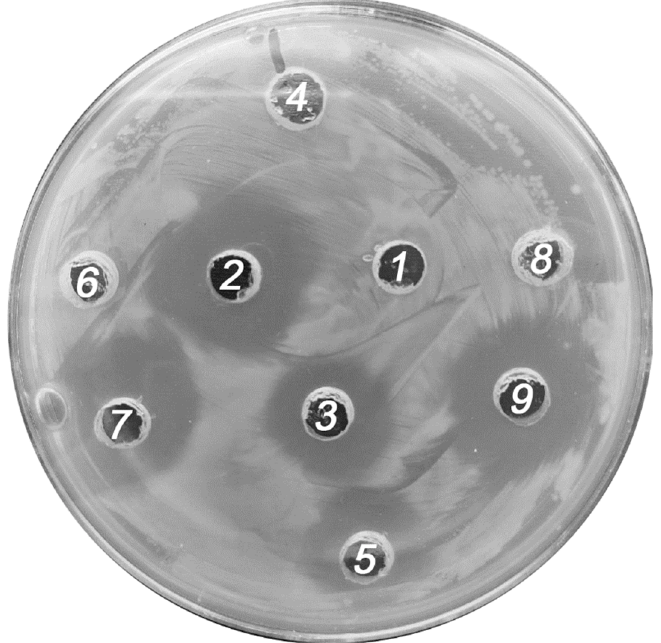
Figure 5. Photo of a Petri dish with agar LB medium inoculated with E. coli , after the formation of sterile zones. There are solutions in the wells: 1—{Mo 72 Fe 30 }; 2— ТС ; 3—{Mo 72 Fe 30 }@ ТС 12.5 ; 4—{Mo 72 Fe 30 } destruction products (DP); 5— ТС +DP; 6—FeCl 3 ∙ 6H 2 O; 7— ТС +FeCl 3 ∙ 6H 2 O; 8— Table 2. The antimicrobial activity towards E. coli strains.